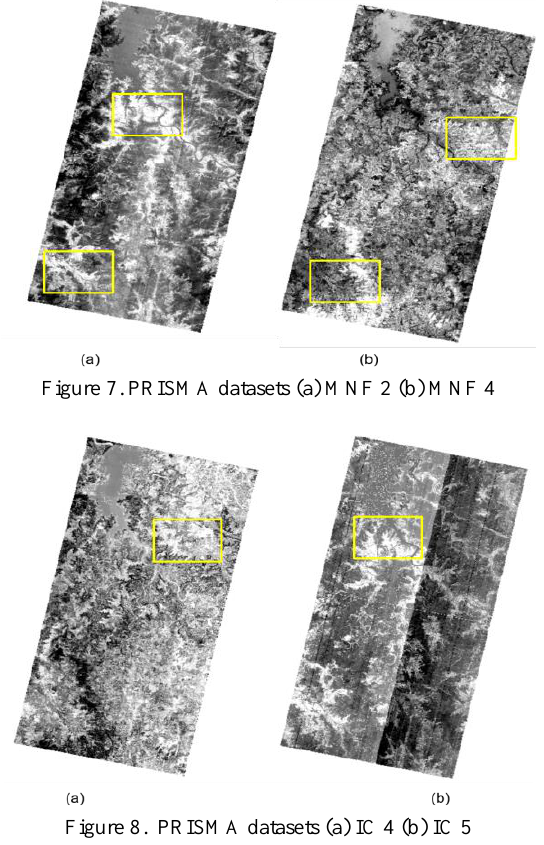
Figure 8. PRISMA datasets (a) IC 4 (b) IC 5